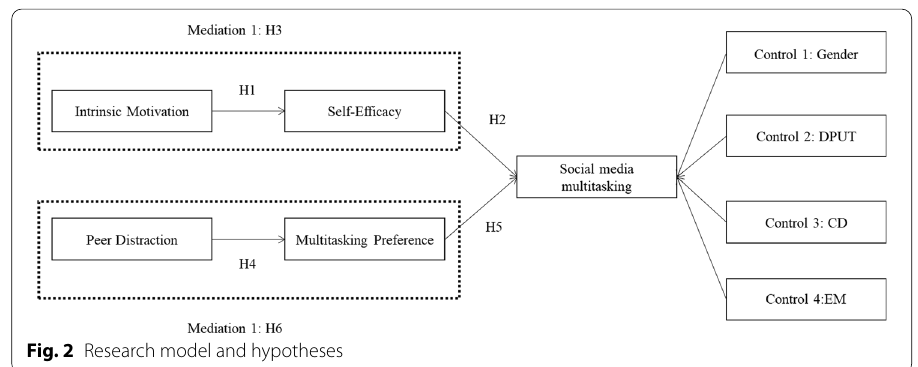
Fig. 2 Research model and